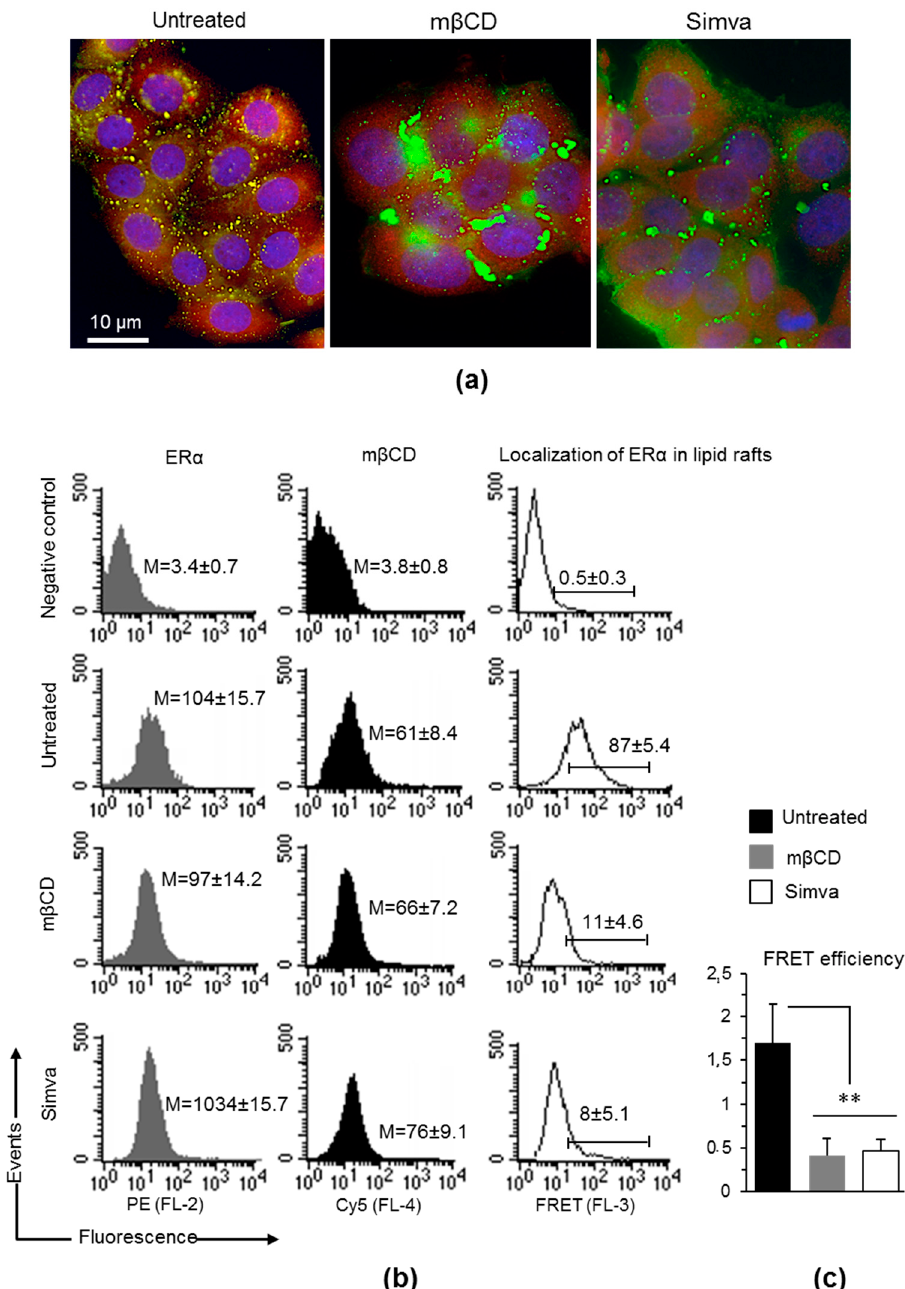
Figure 3. Localization of mER α within lipid rafts. ( a ) intensified video microscopy (IVM) analysis after triple cell staining with fluorescein isothiocyanate (FITC)-conjugated CTxB (green) / ER α (red) / Hoechst (blue) in MCF-7 cells untreated or treated with m β CD or simvastatin. Yellow fluorescence indicates localization of ER α within lipid rafts. Magnification, 700 × . ( b ) Quantitative evaluations by fluorescence resonance energy transfer (FRET) technique of the localization of mER α within lipid rafts (labeled by CTxB), as revealed by flow cytometry analysis. Numbers in the first and second columns (grey and black histograms) indicate the median fluorescence intensity. In the third column (empty histograms) the percentage of FL3-positive events, obtained in one experiment representative of three, is shown. ( c ) Bar graph showing the FRET e ffi ciency, calculated according to the Riemann’s algorithm. Data are reported as mean ± SD from three independent experiments. **, p < 0.01 vs. untreated cell samples by Student’s t test. Simva: simvastatin.